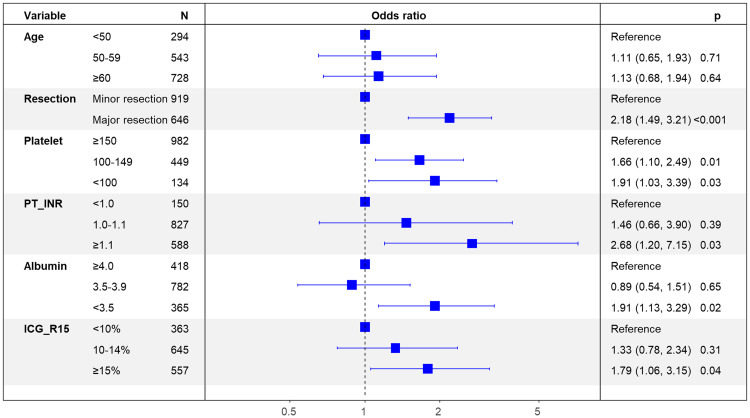
Forest plot of the results of multivariable analysis of factors independently associated with liver-related morbidity after liver resection for hepatocellular carcinoma.